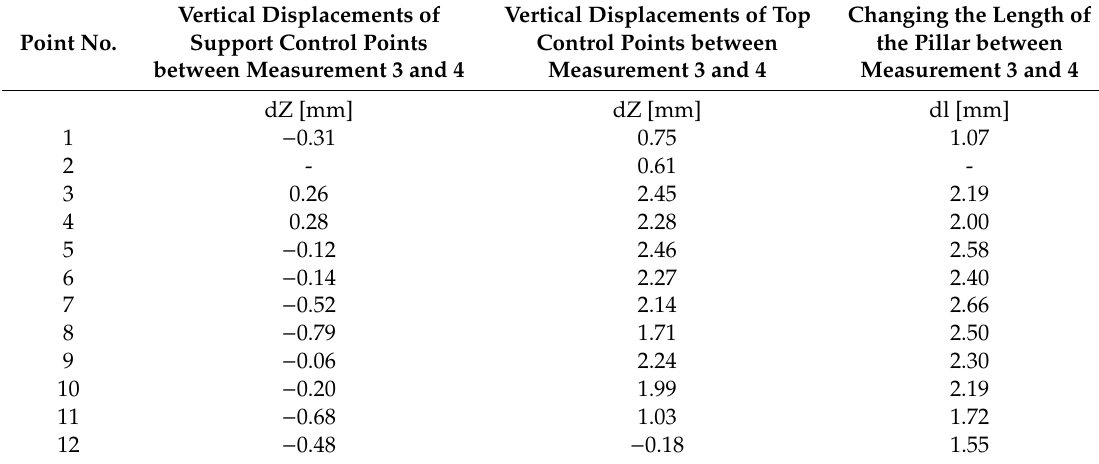
Table 3. Vertical displacements and changing length of the pillars between measurements 3 and 4. Changing the Length of Vertical Displacements of Top Vertical Displacements of the Pillar between Control Points between Point No. Support Control Points Measurement 3 and 4 Measurement 3 and 4 between Measurement 3 and 4 dZ [mm] dZ [mm] dl [mm] − 0.31 0.75